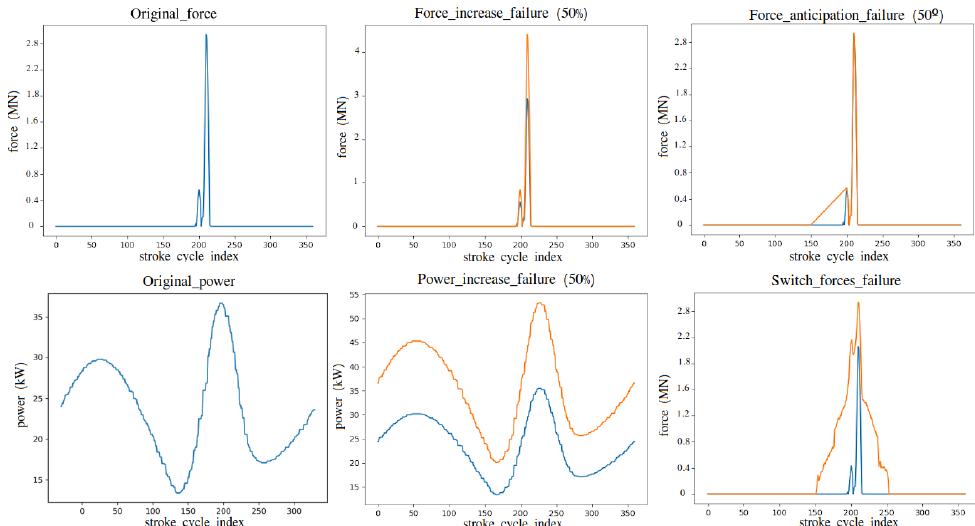
Figure 2. Two correct signals on the left, and the four synthetic failures on the right. Blue signal represents normal stroke data and orange signal represents one corresponding synthetic failure